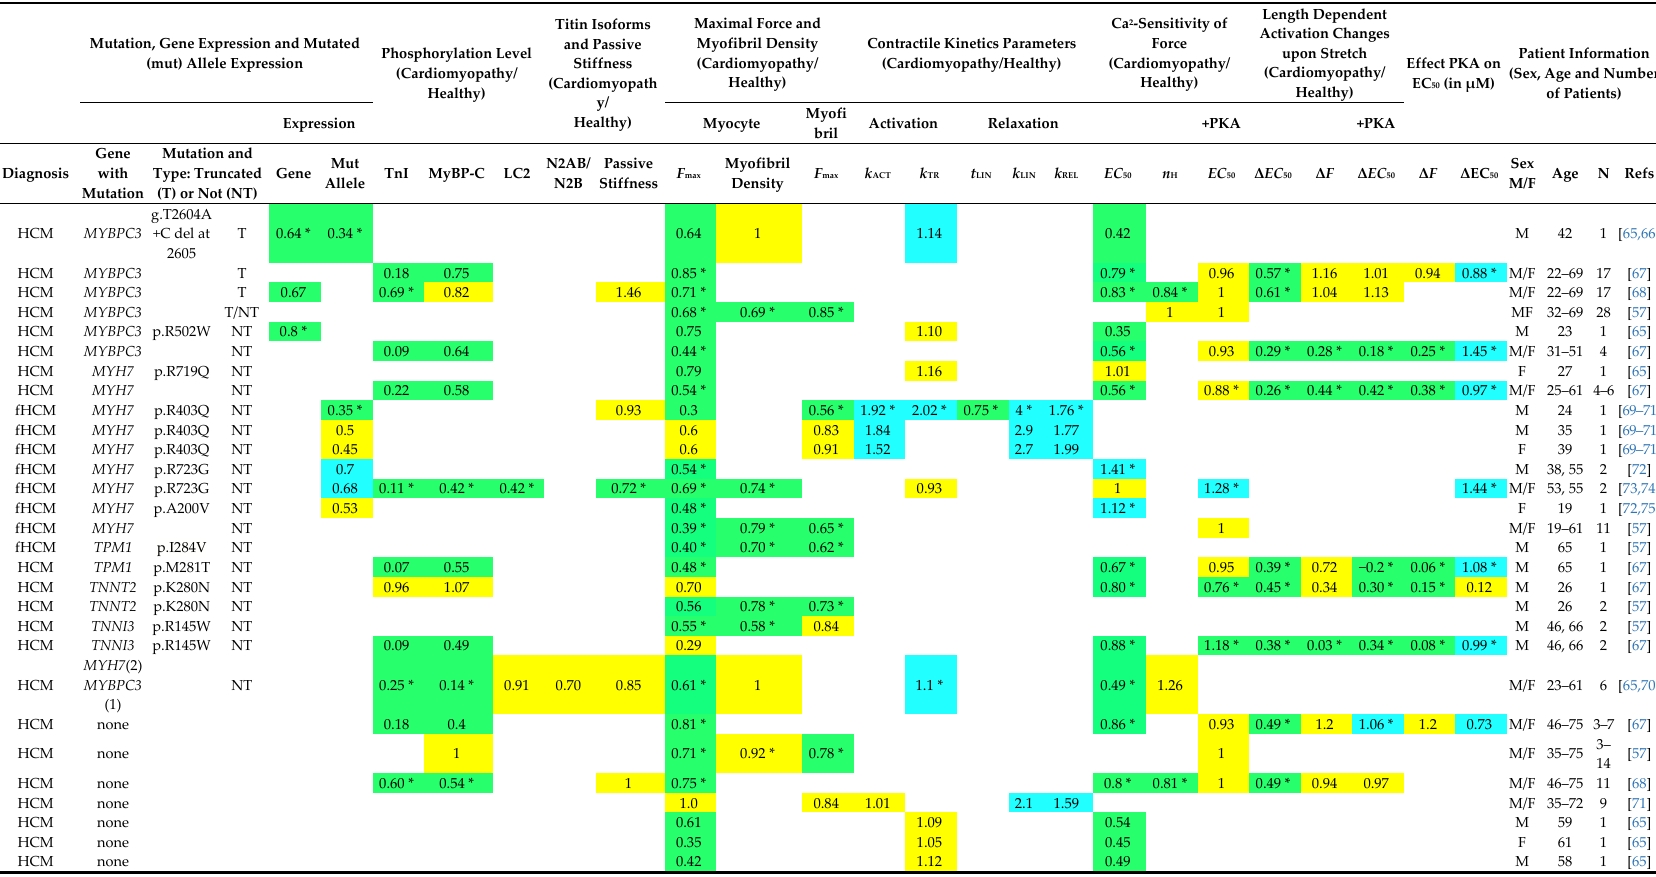
PKA—protein kinase A. The table cells are highlighted according to the value changes compared to control: yellow—no changes, green—the value decreased, blue—the value